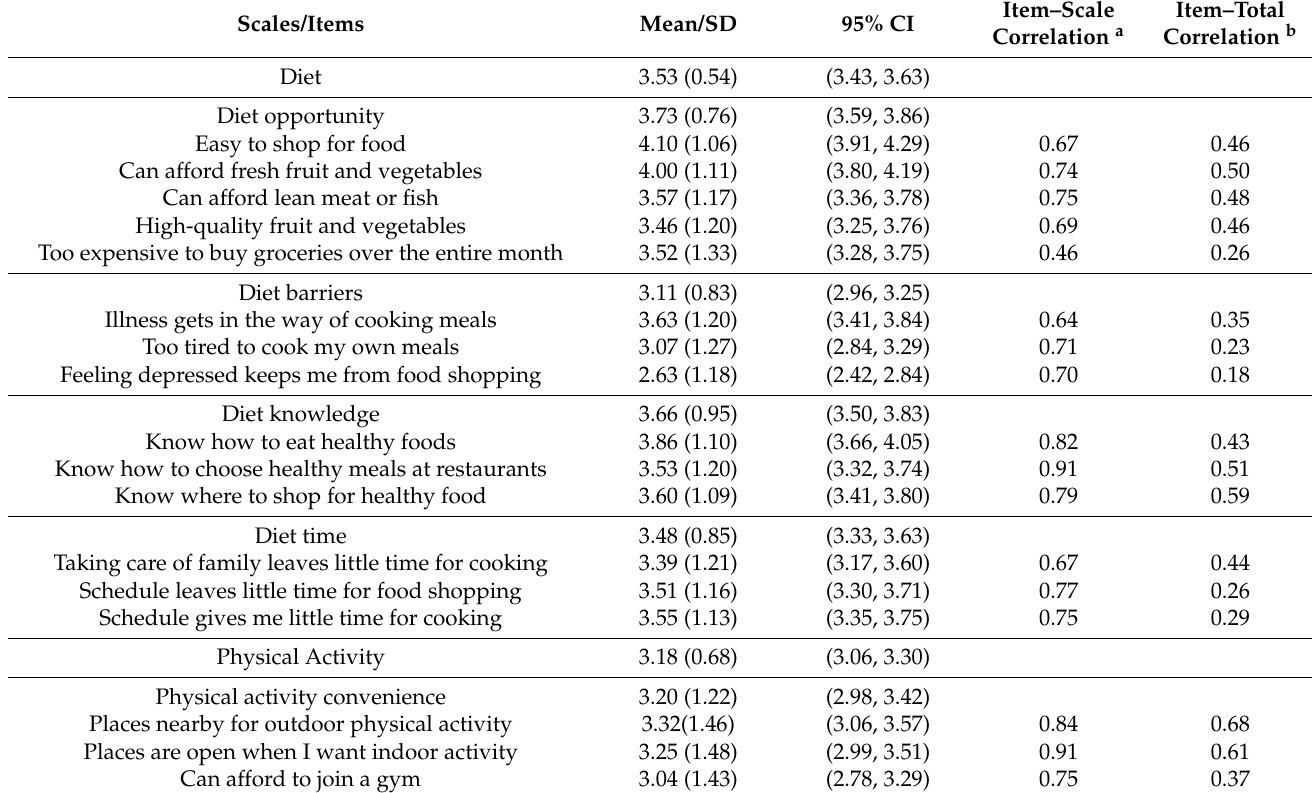
Table 2. Descriptive of CADA items and scale characteristics ( n =